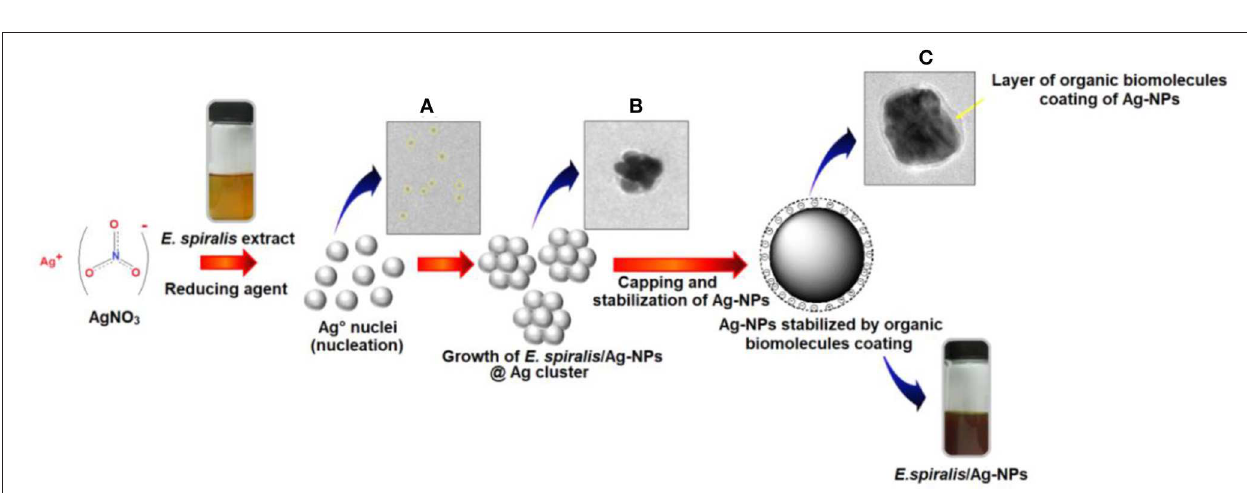
E. spiralis /Ag-NPs are prepared in aqueous solution by the reduction of a dissolved metal precursor of AgNO 3 , using